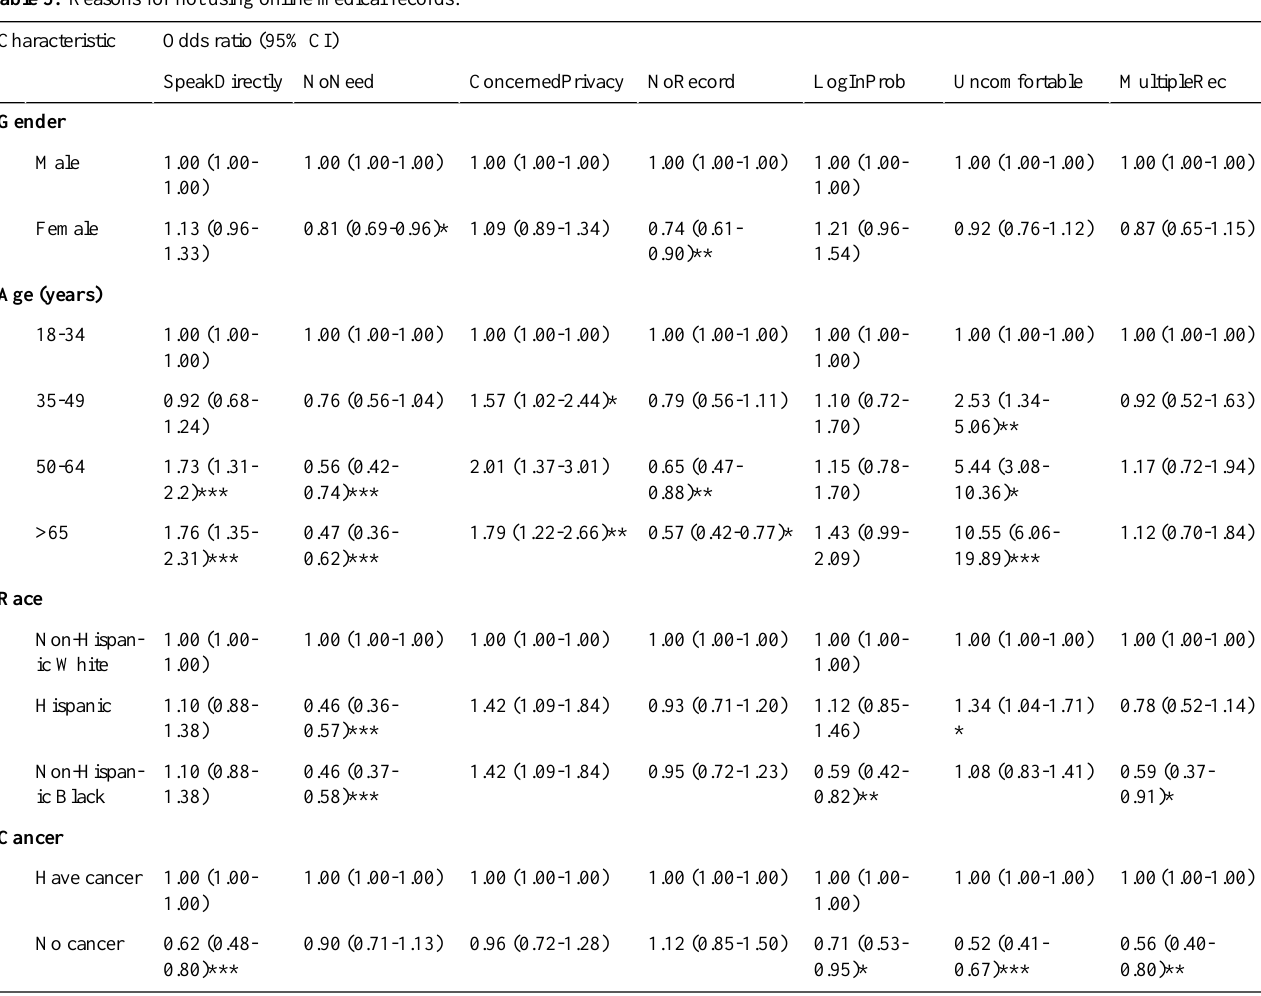
Table 5. Reasons for not using online medical records. Odds ratio (95%